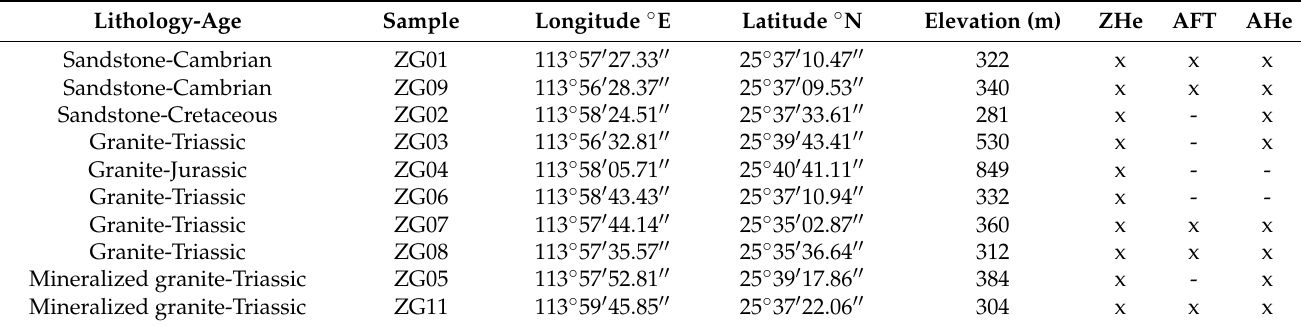
Table 1. Sample locations and lithological information from the Lujing uranium ore